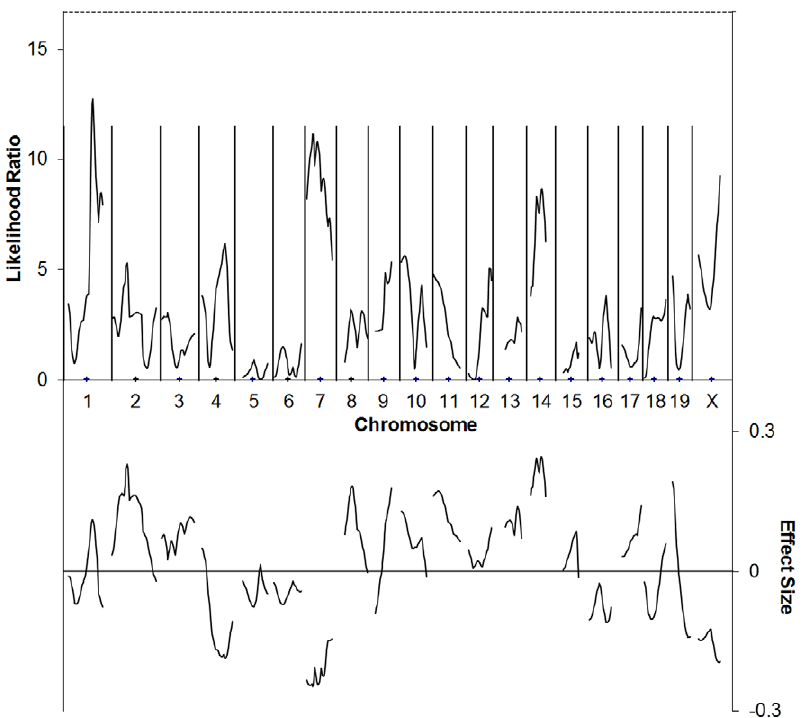
Figure 1. C57BL/6J 6 129P1/ReJ F2 cross simple interval mapping. Whole genome simple interval map. Top: likelihood ratio statistic or likelihood of a region being linked to bFGF-induced corneal neovascularization. Dashed line indicates P=0.05 as determined by bootstrapping. Bottom: predicted additive effect of a region on bFGF-induced corneal neovascularization.